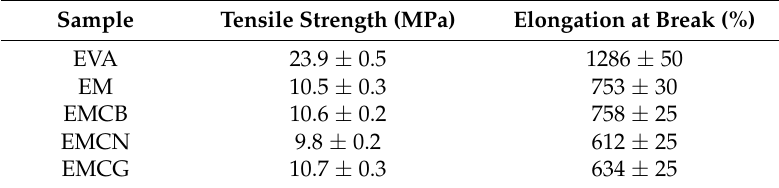
Table 5. Mechanical properties of pure EVA and its